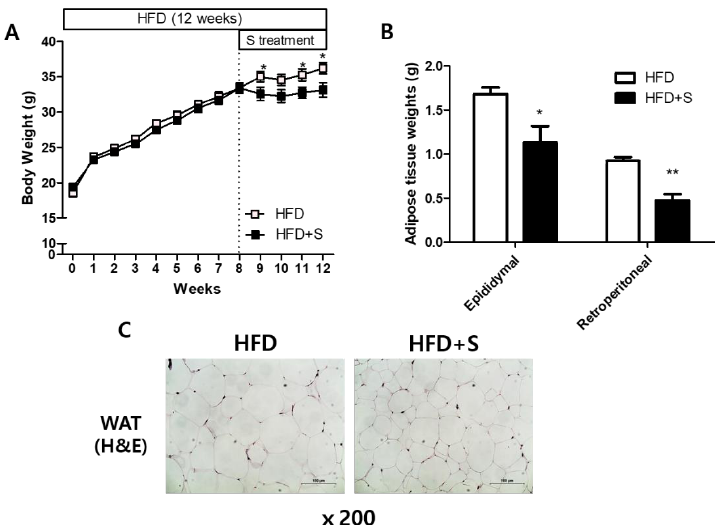
Figure 5. Shikonin reduces body weight and white adipose tissue (WAT) weight. ( A ) Body weight, ( B ) weights of epididymal WAT and retroperitoneal WAT, ( C ) epididymal fat tissue morphology in high fat diet (HFD)-fed mice. The results were expressed as mean ± SEM. *, p < 0.05.